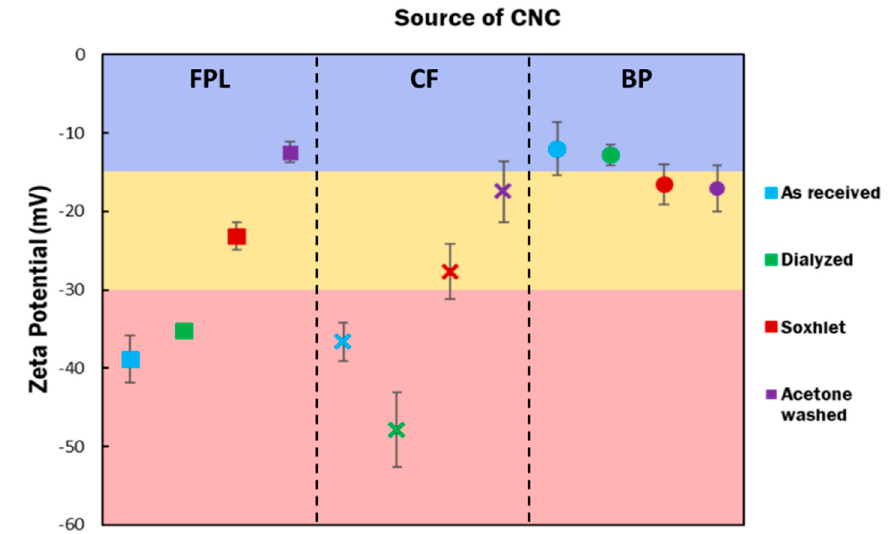
Figure 6. Zeta potential values of CNCs (squares are FPL, crosses are CF, and circles are BP), as received and after post-treatments (blue is as received, green is dialyzed, red is Soxhlet extracted, and purple is acetone washed). Regions are colored to highlight amount of charge—blue is low to no charge, yellow is moderately charged, and red is highly charged.